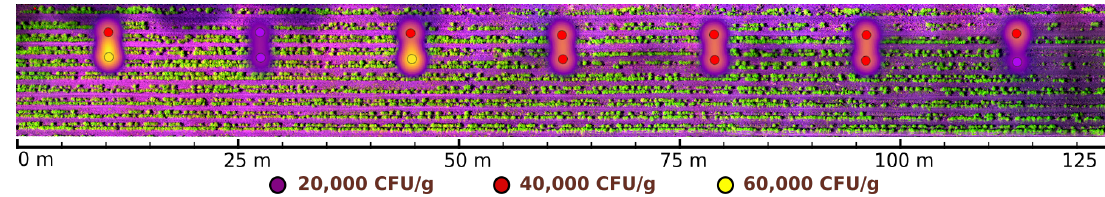
Figure 13. Colony forming unit (CFU)/g of Mortierella sp. detected at sampled